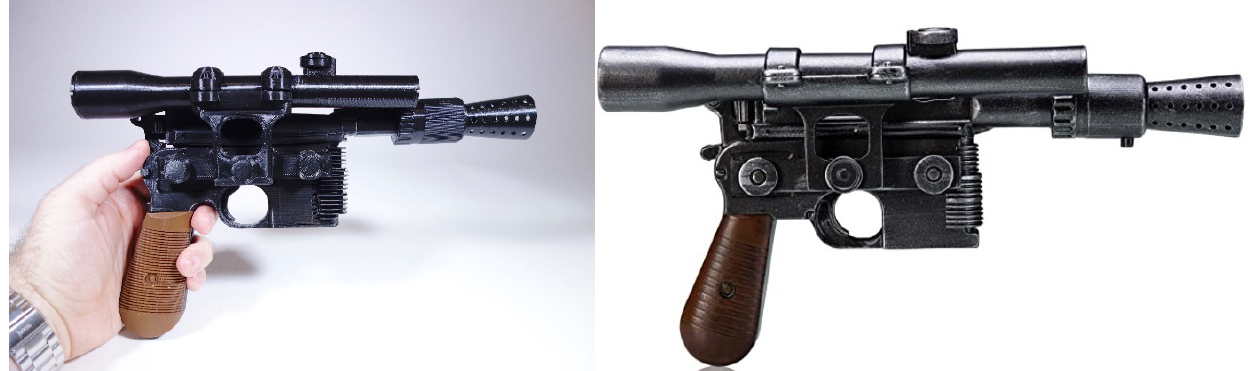
Figure 2: Comparison of open source version (left) and the commercial version (right) of the blaster toy (rockets2, 2021; Amazon, 2021b).